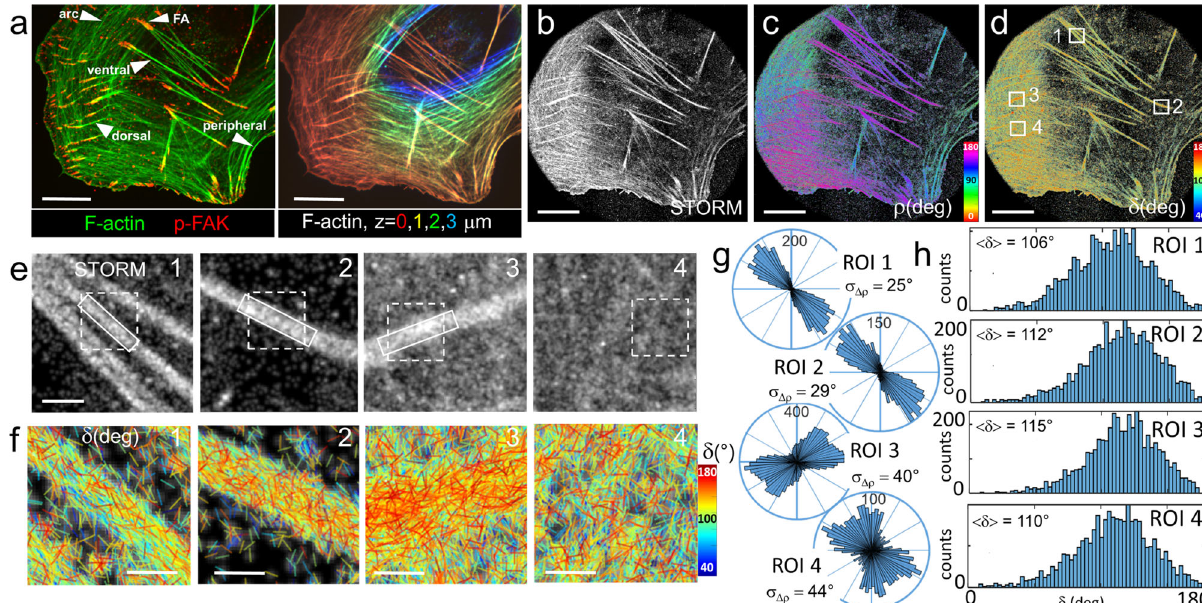
Fig. 2 4polar-STORM imaging of actin fi lament organization in fi xed U2OS cells. a Left: Spinning-disk fl uorescence image of a U2OS cell (green, AF488- phalloidin-labeled F-actin; red, p-FAK). White arrows indicate focal adhesions (FAs) and the types of stress fi bers (SFs) of interest. Right: z-stack mage of F-actin, z is color-coded as indicated. b Large fi eld of view single-molecule (AF488) localization STORM image of the same cell. c Corresponding 4polar- STORM ρ stick image with color-coded orientation measurements. d Corresponding 4polar-STORM δ stick image with color-coded wobbling angle measurements. e STORM of zoomed regions of interest (ROI) (squares in ( d )). ROI 1, ventral SF; ROI 2, FA; ROI 3, dorsal SF; ROI 4, meshwork. f δ stick images of zoomed regions (dashed squares in ( e )). 4polar-STORM images were repeated independently on three different samples (3 – 5 cells per sample) with similar results. g Polar-plot histograms of ρ in the rectangle region indicated in ( e ) (whole region for ROI 4), with corresponding standard deviation σ Δρ values of Δρ = ρ − < ρ >. h Histograms of δ values for ROIs 1 – 4, with corresponding values of < δ > over all measured molecules. For all images, intensities are thresholded above 1100 photons and localization precisions are thresholded below 0.15 pixels ( σ loc < 20 nm). Scale bars ( a – d ), 7 μ m; ( e ), 800 nm; ( f ), 260 nm. Source data are provided as a Source Data fi